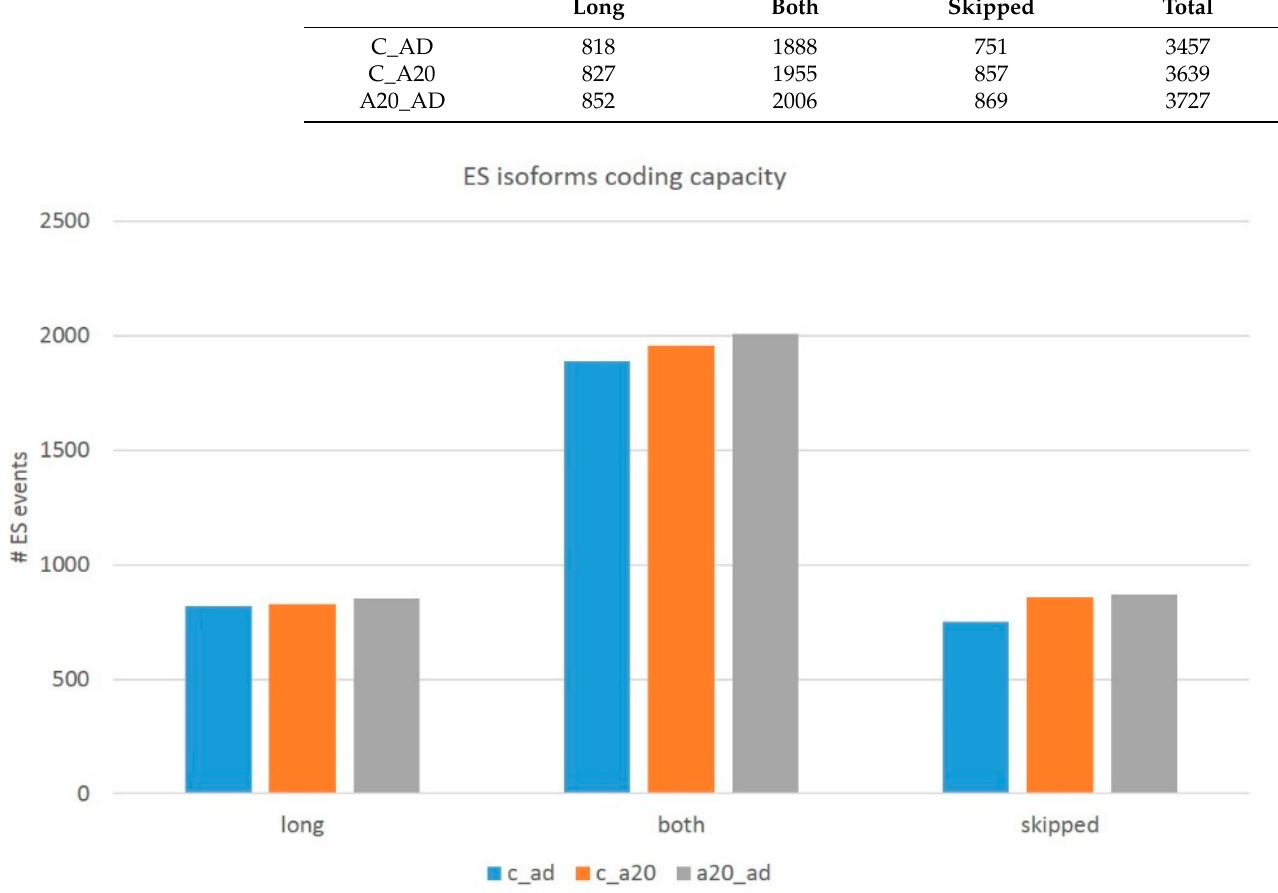
Figure 16. Table 4—inferred plot on the protein competent ES events implies consistency in the overall distribution: only half of the ES events maintain both long and short coding isoforms. Ab- breviations: long, long coding isoform alone; both, both isoforms are coding; and skipped, skipped coding isoform alone.